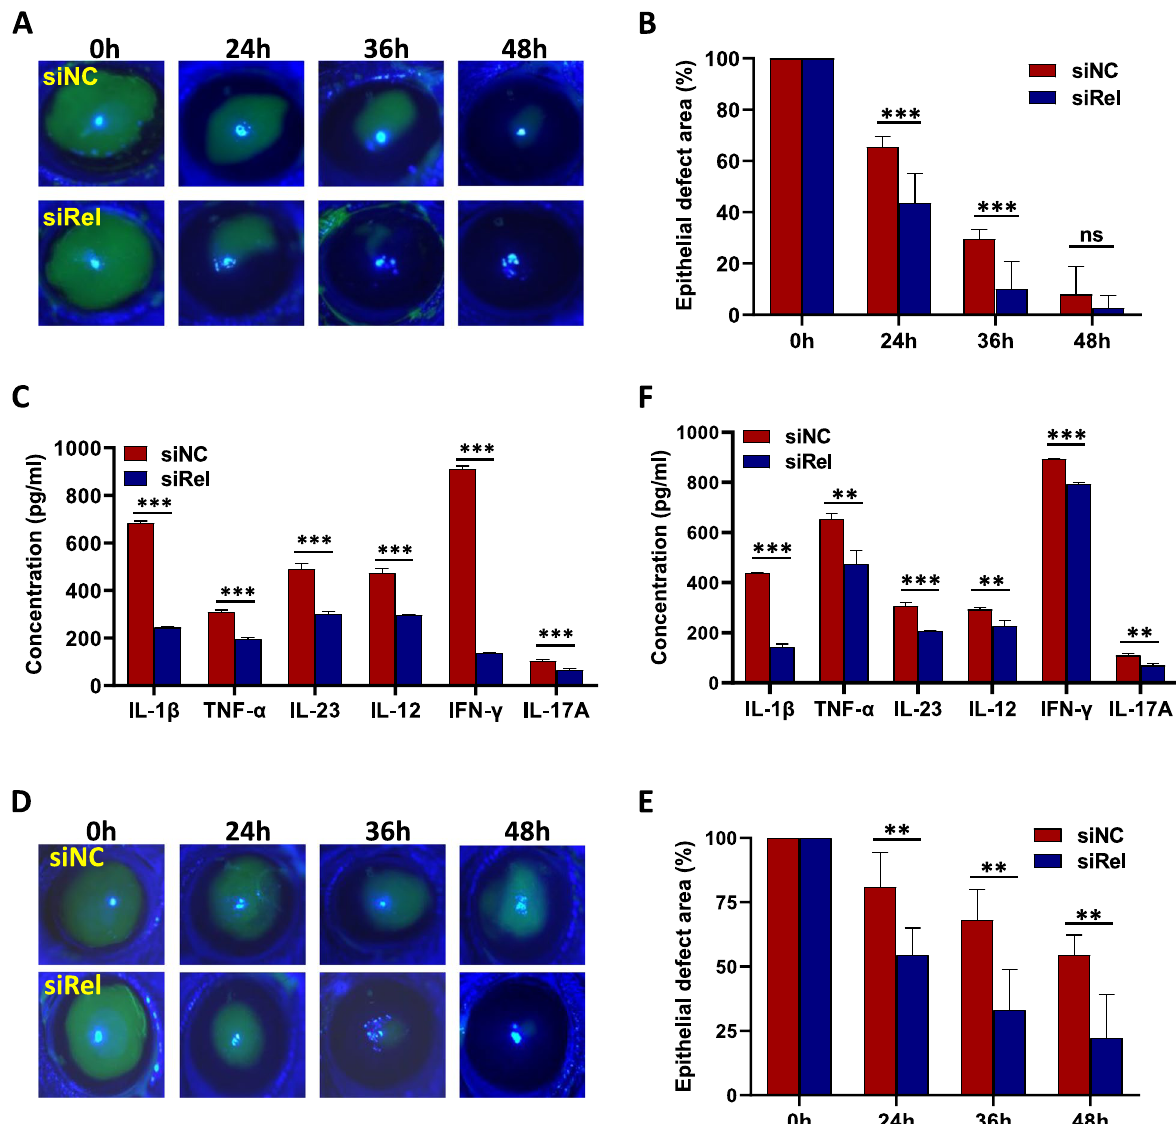
Fig. 3 Topical treatment on the corneal surface with nano-polymers loaded with siRel can effectively accelerate corneal wound healing. A – C Corneal epithelial wound healing model was established in normal mice. Nano-polymers loaded with siNC ( n 8) or siRel ( n 8) were topically = = applied to the corneal surface immediately after corneal epithelial scraping and at 12 h, 24 h, and 36 h hereafter. Corneal epithelial wounds were stained with fluorescein sodium and examined under a slit lamp microscope at the indicated time points ( A ). Statistical analysis was performed on the corneal epithelial defect area using Image J software ( B ). Corneal tissue extracts were prepared at 24 h after corneal epithelial scraping and the production of inflammatory cytokines as indicated in the figure was determined by ELISA ( C ). D–F A corneal epithelial wound healing model was established in diabetic mice. Nano-polymers loaded with control siRNA ( n 6) or siRel ( n 6) were topically applied to the corneal surface = = as described in A–C . Corneal epithelial wound staining ( D ), statistical analysis of corneal epithelial defect area ( E ) , and detection of inflammatory cytokine production in corneal extracts ( F ) were then performed also as described in A–C . For A , C , D, and F , results shown are representative of two independent experiments. For B and E , results shown are combined from two independent experiments. * P <0.05, ** P <0.01, *** P